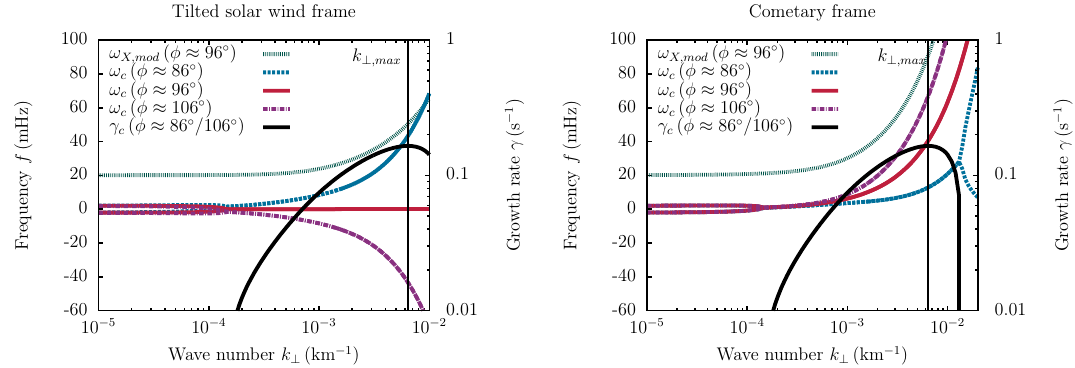
(φ ≈ 96 ◦ ) and the ambient magnetic field B 0 . The modified X-mode Figure 3. Wave propagation perpendicular to the cometary current j c (green) is labelled ω X, mod and both branches of the cometary ion mode ω c (red) are shown. Additionally, the cometary ion branches close to the perpendicular direction (φ ≈ 86 ◦ / 106 ◦ ) (blue/violet) and their growth rate (black) with a maximum at k ⊥ , max ≈ 6 . 4 × 10 − 3 km − 1 (λ max ≈ 980km ) are presented, since for φ ≈ 96 ◦ the growth rate (not shown) only approaches an upper limit γ c, res ≈ 0 . 40s − 1 . TSW and the cometary rest frame are shown in the left and right panels, respectively.